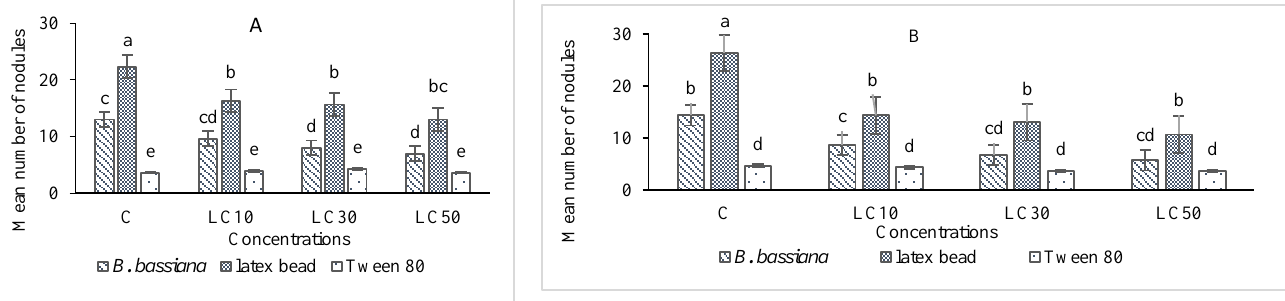
Figure 3. Effects of Artemisia annua floral essential oil on the nodule formation of Glyphodes pyloalis larvae treated with oral ( A ) and fumigant assays ( B ) and inoculated with Beauveria bassiana spores or latex beads. Bars with different letters indicate significant differences between means at p < 0.05. Tukey’s test. The number of hemocytes ×10 4 . Foods 2020 , 9 , x FOR PEER REVIEW